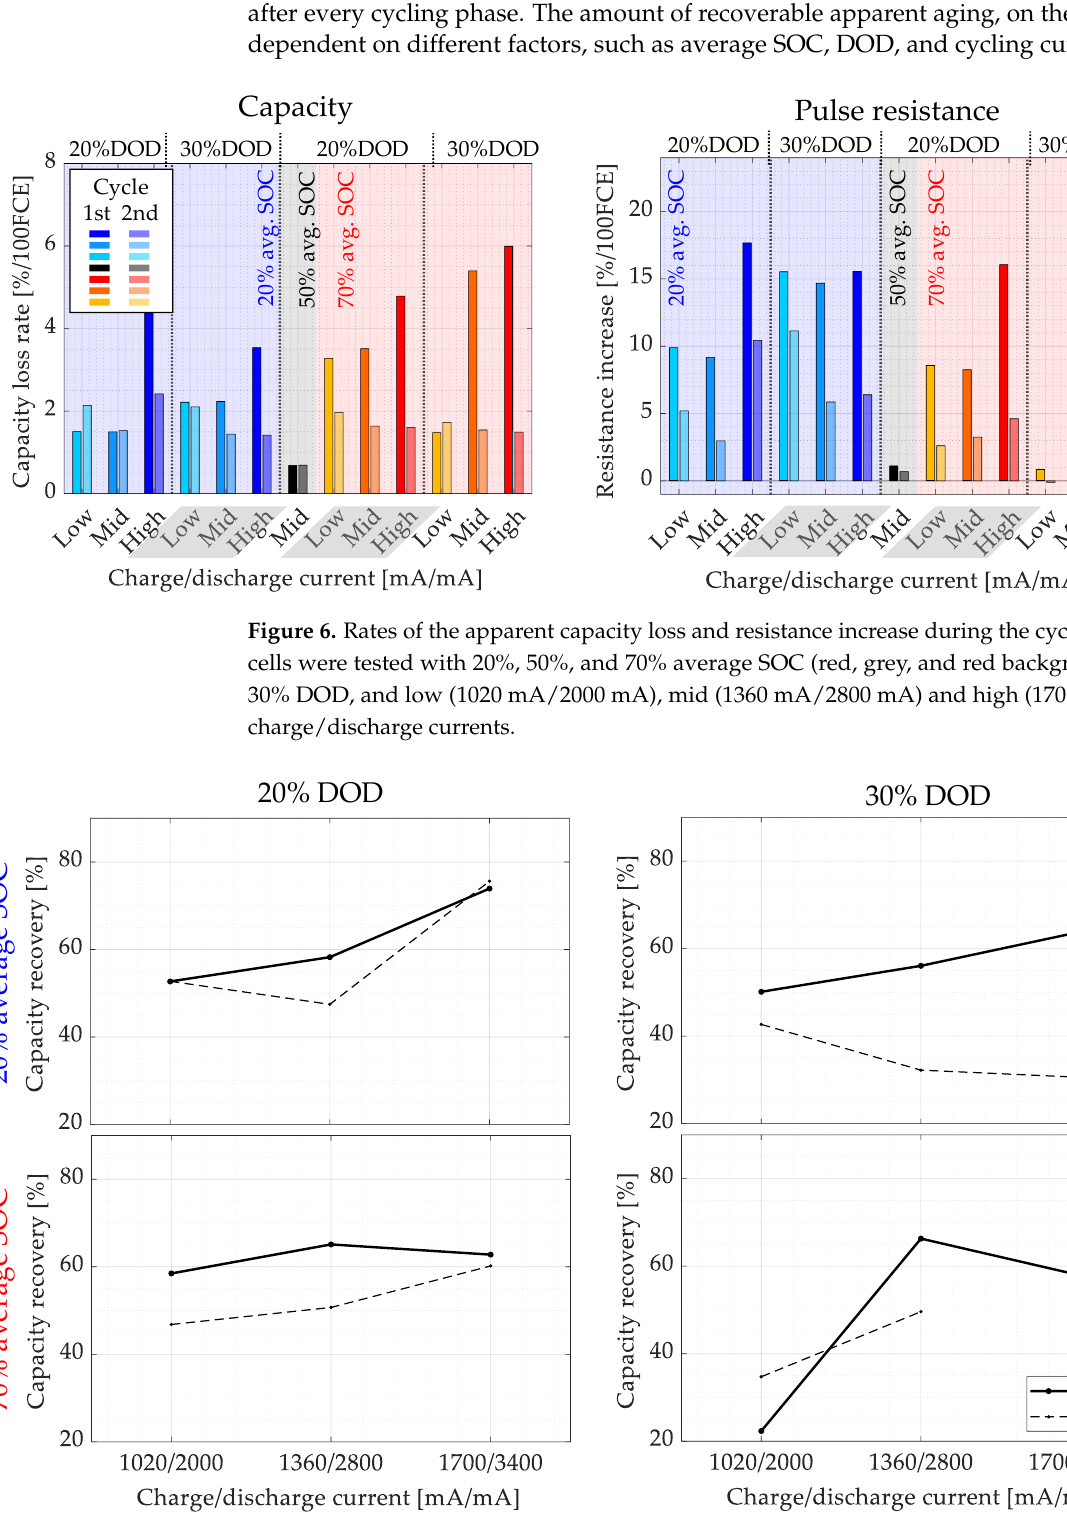
Figure 7. Capacity recovery during the resting phases for the first and second cycles. The cells were tested with 20% and 70% average SOC, and 20% and 30% DOD and low (1020 mA/2000 mA), mid (1360 mA/2800 mA), and high (1700 mA/3400 mA) charge/discharge current intensities.